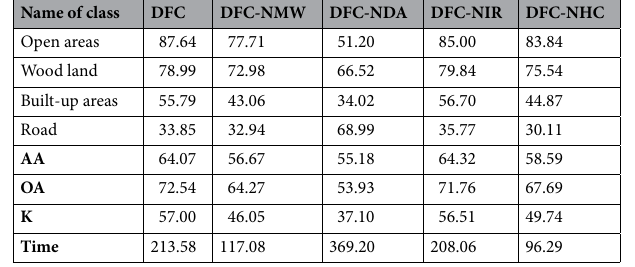
Table 5. Classification results for Oberpfaffenhofen dataset achieved by using 100 training samples per